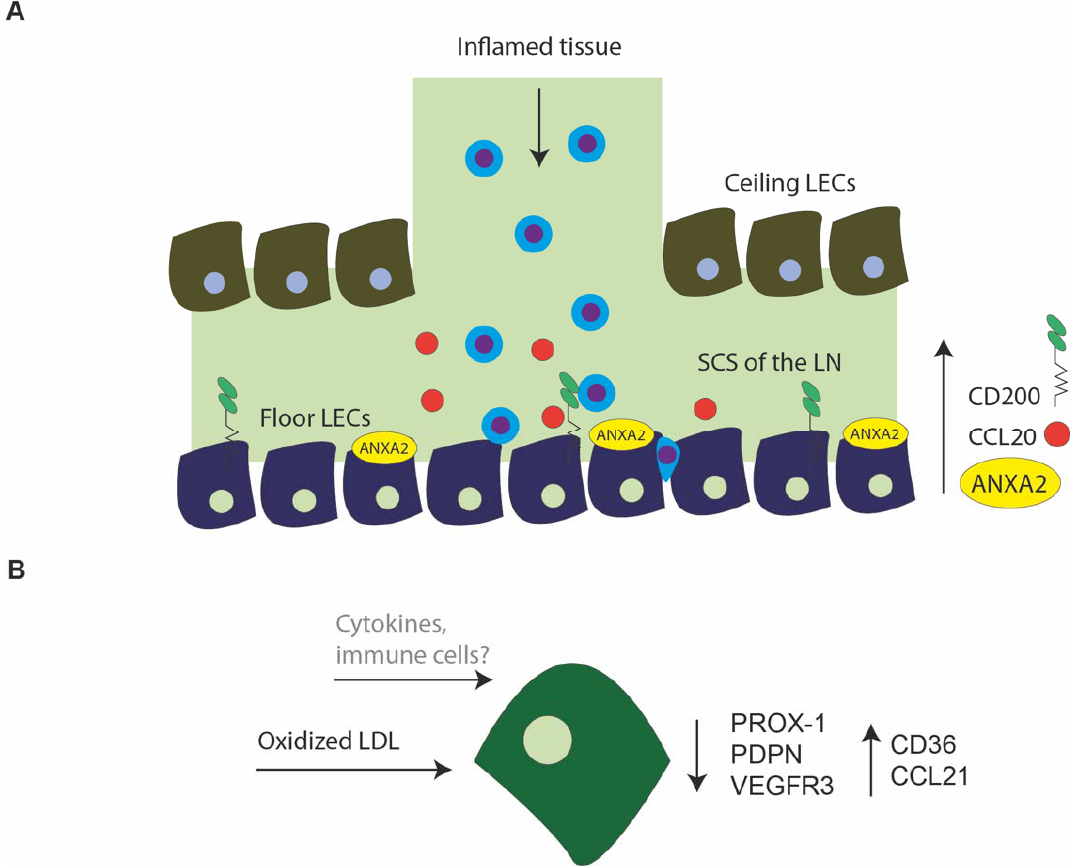
Figure 3. Inflammatory changes in lymph node lymphatic endothelial cells and peripheral lymphatic endothelial cells. ( A ) Predominantly, lymphatic endothelial cells (LECs) lining the floor of the subcapular sinus (SCS) (floor LECs) come into contact with immune cells of inflamed tissue. Floor LECs can rapidly upregulate the expression of chemokines, such as chemokine (C-C motif) ligand 20 (CCL20). Additionally, molecules such as Annexin A2 (ANXA-2) and cluster of differentiation 200 (CD200) are upregulated. The function of these molecules in the inflamed LN needs to be investigated. ( B ) Oxidized low-density lipoprotein (LDL) can downregulate transcripts like Prospero Homeobox Protein 1 (PROX-1), Podoplanin (PDPN), and Vascular Endothelial Growth Factor Receptor 3 (VEGFR3), which are key LEC markers. CD36, a fatty acid transporter, and CCL21 are upregulated. Single cell RNA sequencing (ScRNA-seq) data on inflammatory changes by cytokines or immune cells have not yet been